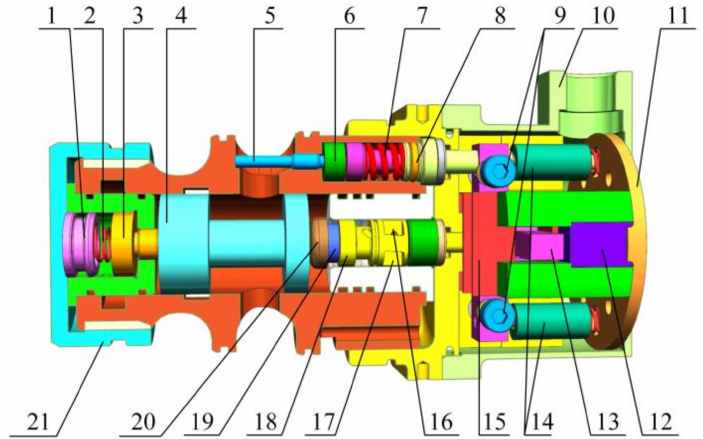
Figure 1. Schematic diagram of 2D electric feedback flow control valve. 1. plug; 2. reset spring;